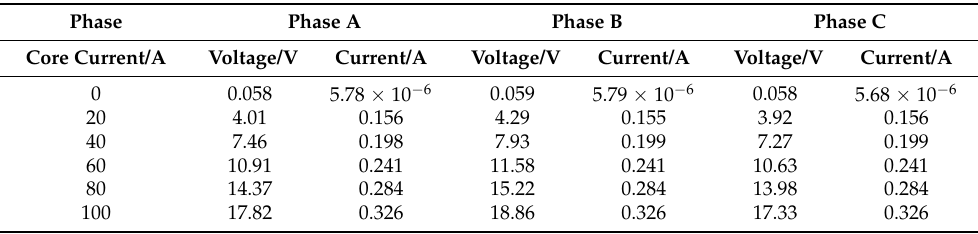
sheath protector when there is no